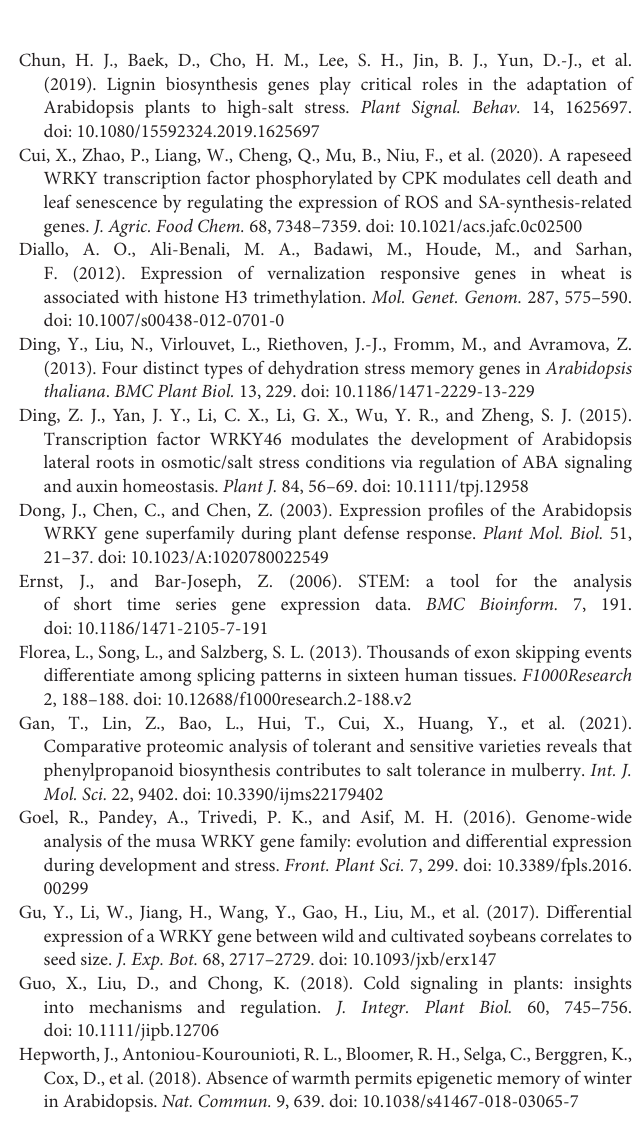
Supplementary Figure 4 | All expression profiles of DEGs in Longyou-7 in the six sampling stages. Supplementary Figure 5 | All expression profiles of DEGs in Tianyou-4 in the six sampling stages. Supplementary Figure 6 | Top 12 families of differentially expressed transcription factors in different stages of (A) Longyou-7 (L7), (B) Tianyou-4 (T4), and (C) Lenox. Supplementary Figure 7 | Venn diagrams of SNPs, INDELS, and alternative splicing events identified in Longyou-7, Tianyou-4, and Lenox, respectively. Supplementary Figure 8 | qRT-PCR analysis of 11 selected DEGs with different expression patterns in the RNA-seq data in six sampling stages. Histograms represent transcript abundance (FPKM) of the RNA-Seq data (left y -axis), and line charts represent the relative expression levels of means ± SD from three independent biological replicates by qRT-PCR (right y -axis). The data of the relative expression levels in the S1 stage were set to 1. Correlation between the RNA-Seq and the qRT-PCR of the 11 selected DEGs was also